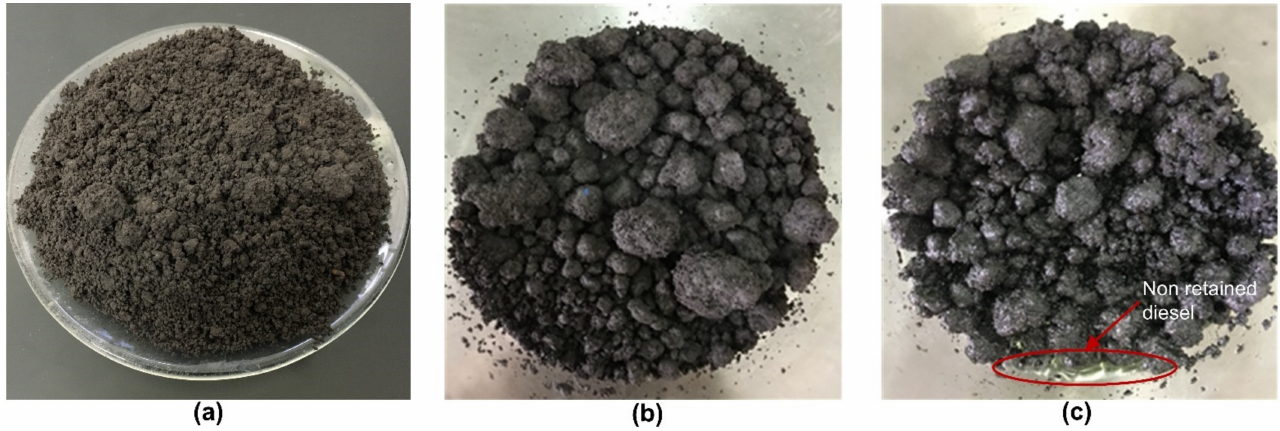
Figure 1. Evolution of soil aspects as diesel concentration increased from: ( a ) natural soil, ( b ) 4% added diesel, and ( c ) 14% added